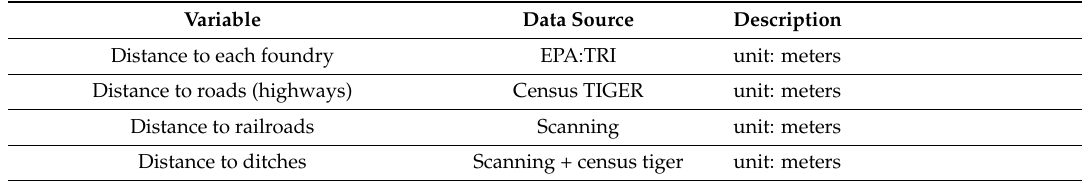
Table 1. List of physical variables used for the regression